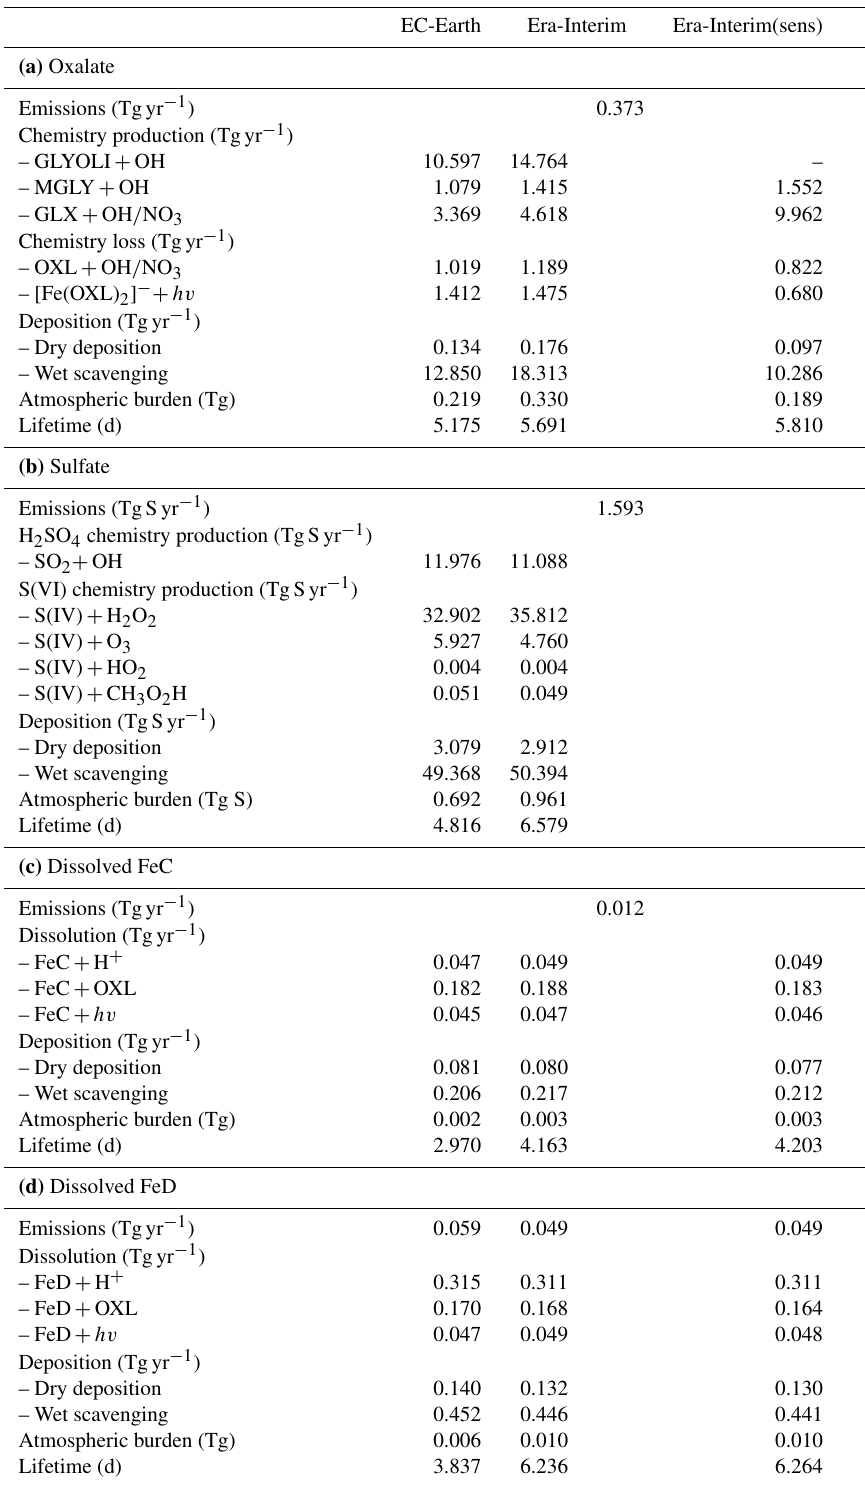
Table 2. Global budgets, atmospheric burdens, and lifetimes, averaged for the period 2000–2014, of (a) oxalate (OXL), (b) sulfate, and dissolved Fe-containing aerosols from (c) combustion processes (FeC) and (d) mineral dust (FeD) for EC-Earth, ERA-Interim, and ERA- Interim(sens)